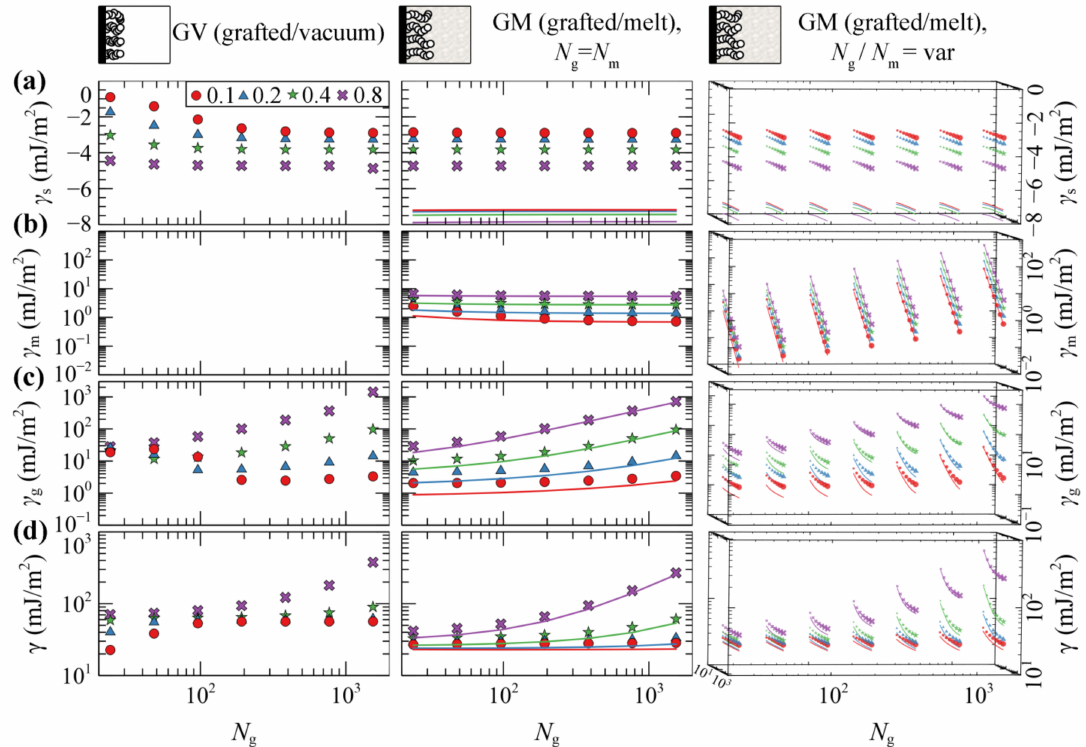
Figure 5. Partial contributions to the grand potential ( a ) γ s , ( b ) γ m , and ( c ) γ g , and ( d ) total grand potential, γ , per unit area, using the SL-SGT (markers) and HFD (solid lines) EoS. The panels on the left column correspond to the GV system. The panels in the central column depict results regarding the GM system, for N g = N m . The rightmost column depicts results for the GM system as well, but with N m varying from 24 up to 1536 segments. Different colors and symbols denote different values of the surface grafting density; σ g = 0.1 (red/circles), 0.2 (blue/triangles), 0.4 (green/stars) and 0.8 (violet/crosses) nm –2 . The chain length of grafted chains increases implicitly in each panel from left to right, according to the scaling law expression presented in the labels of the x -axis. In the rightmost column the size of the symbols increases with the chain length of matrix chains. All cases have been evaluated in the absence of the ramp